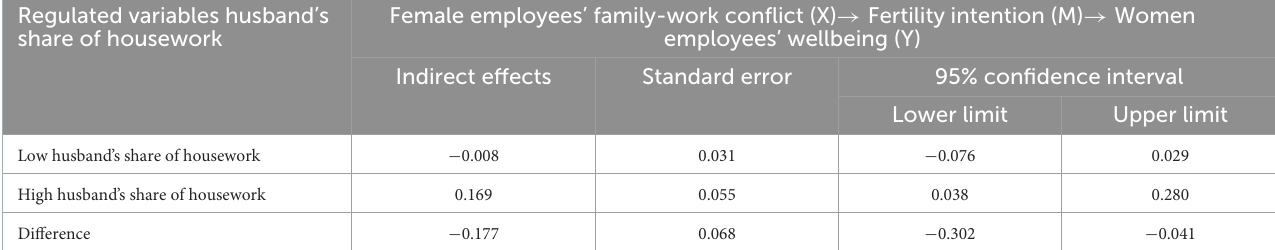
TABLE 7 Results of the test for mediating effects of being moderated at two stages (family-work conflict for female employees as independent variables). Regulated variables husband’s share of